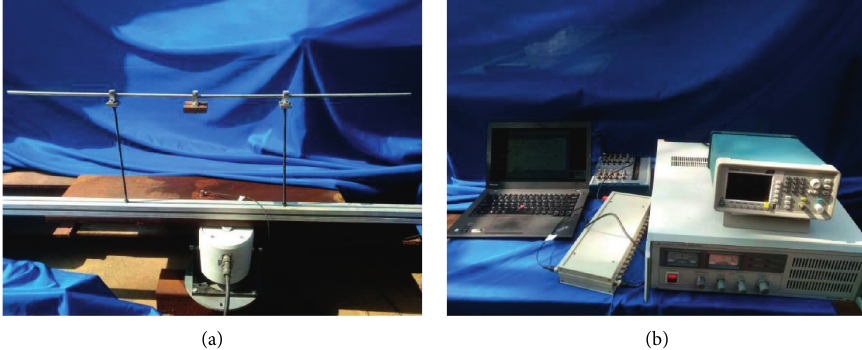
Figure 7: The experimental setup and data acquisition system.